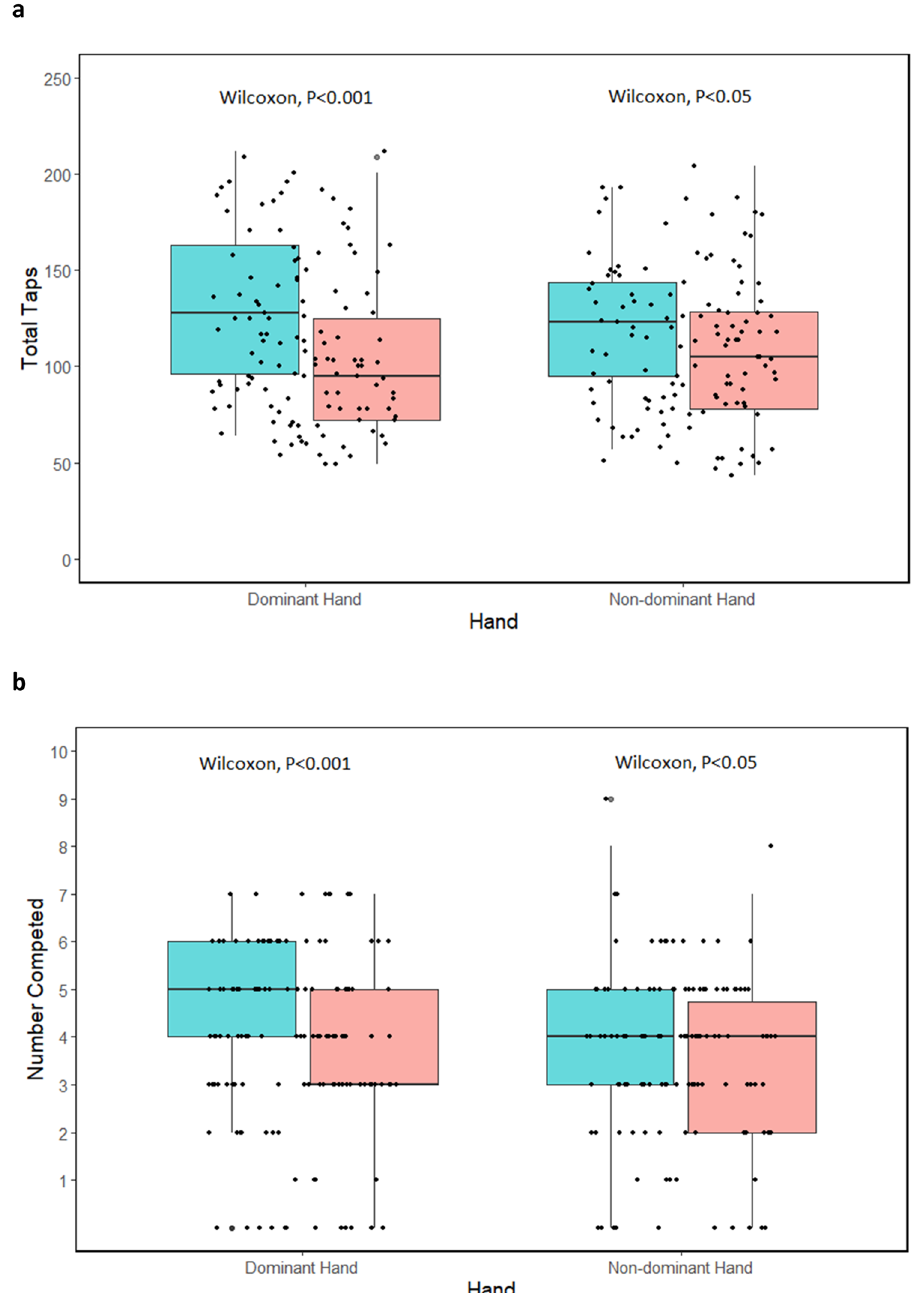
Fig. 2 Comparisons of psychomotor function derived from a smartphone. Box plots for (panel a ) number of total fi nger taps and (panel b ) number of objects successfully manipulated on a smartphone between those with and without Parkinson ’ s disease by dominant and non- dominant